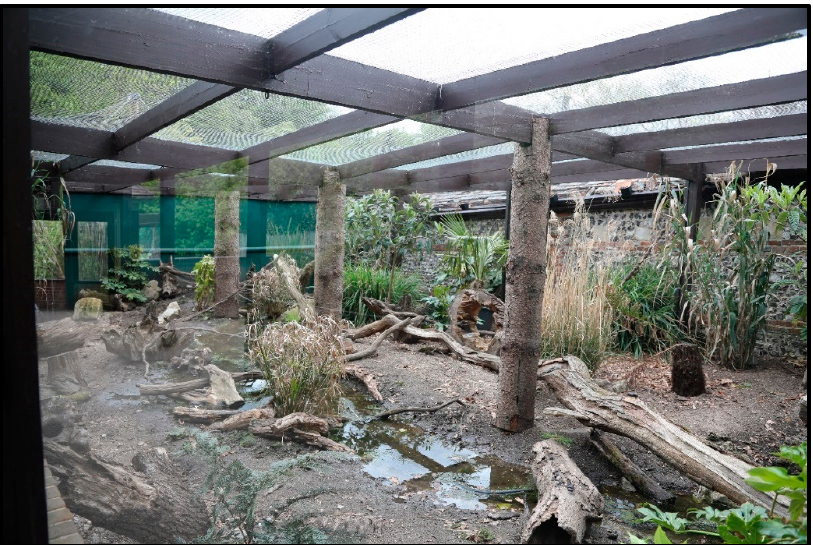
Figure 2. Outside habitat for C. obscurus, MZ. Environmental features include a stream, a variety of planting, a mesh roof and